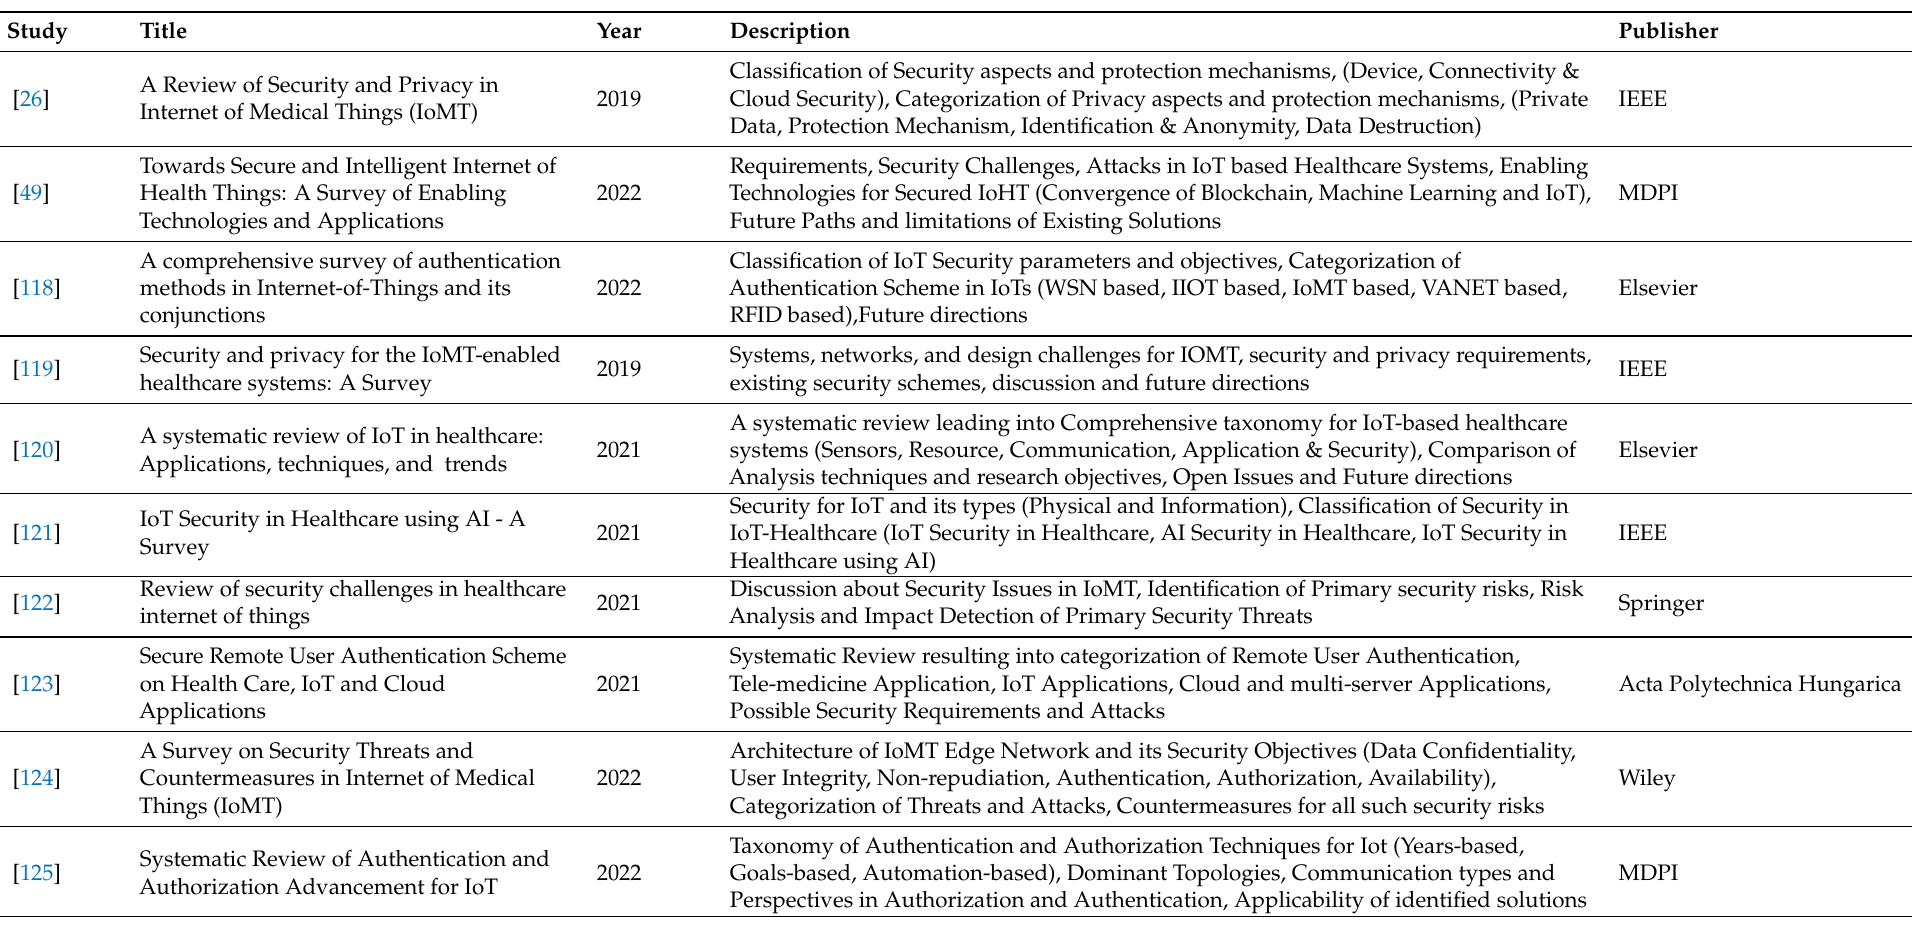
Table 5. Overview of existing surveys of security in IoT-enabled healthcare